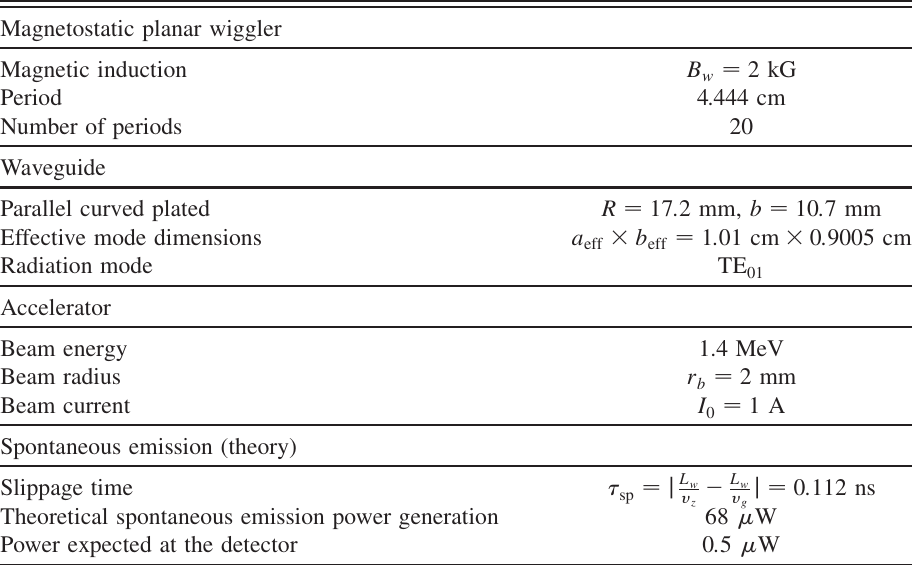
TABLE I. Typical operation parameters of the Israeli EA-FEL. Magnetostatic planar